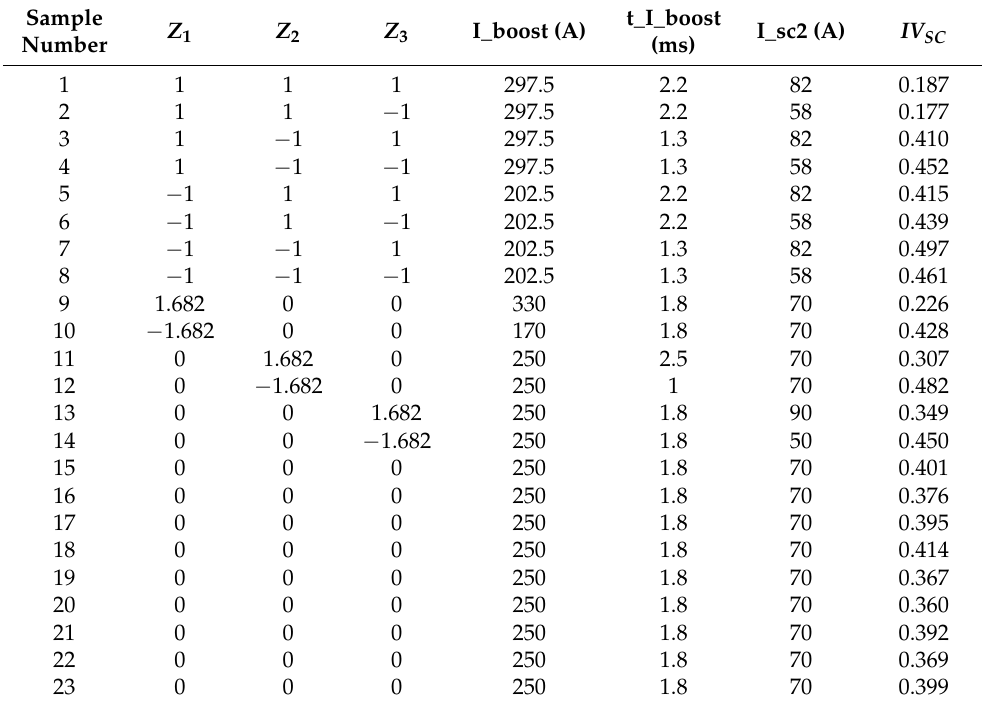
Table 6. Design table of the CMT characteristic parameters and the corresponding IV SC